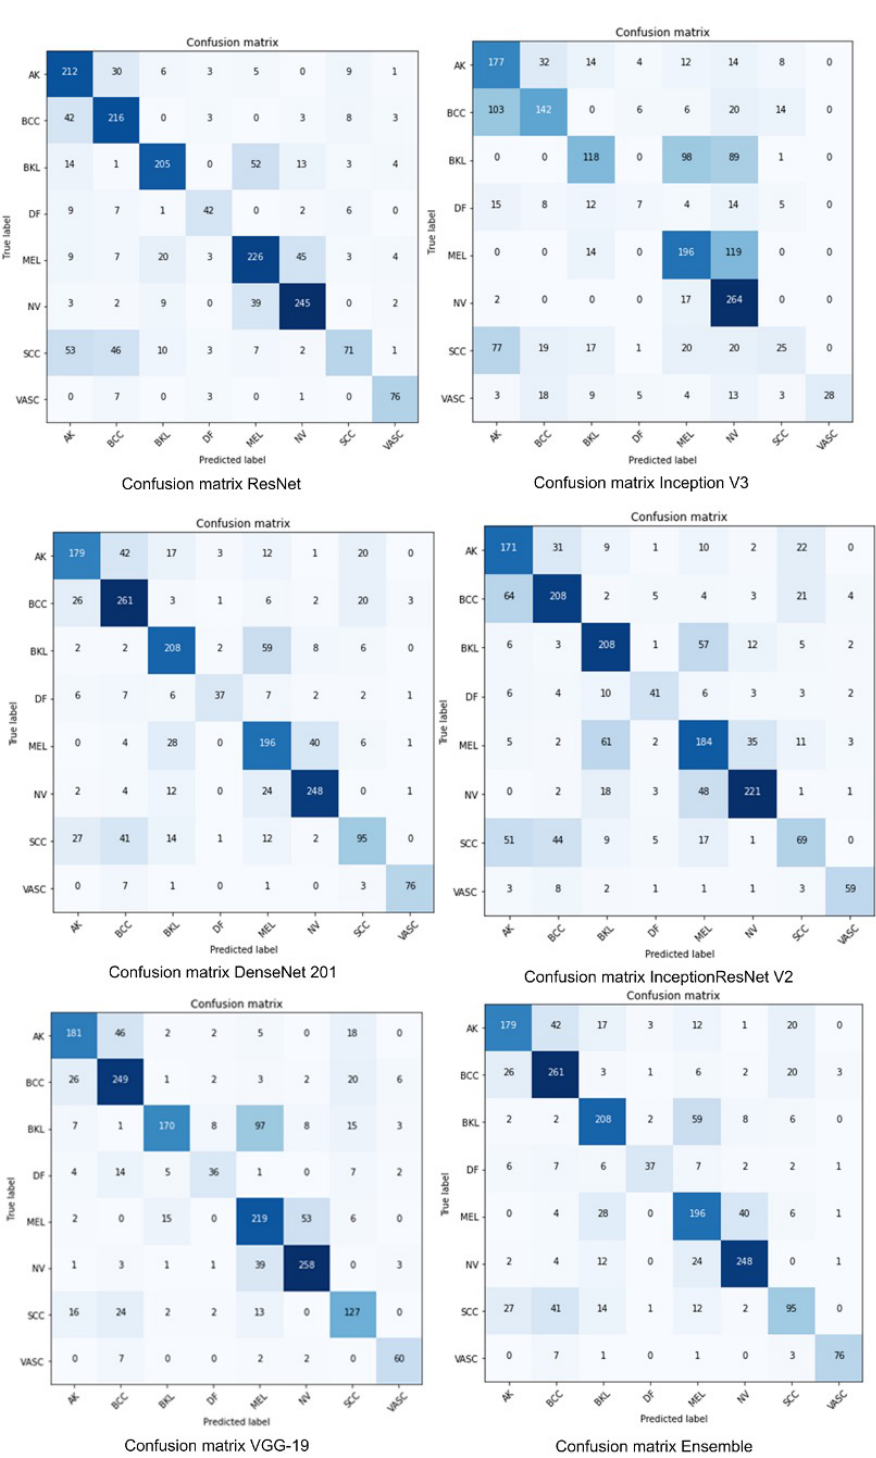
Figure 7. Confusion matrix-based performance of individual and proposed ensemble